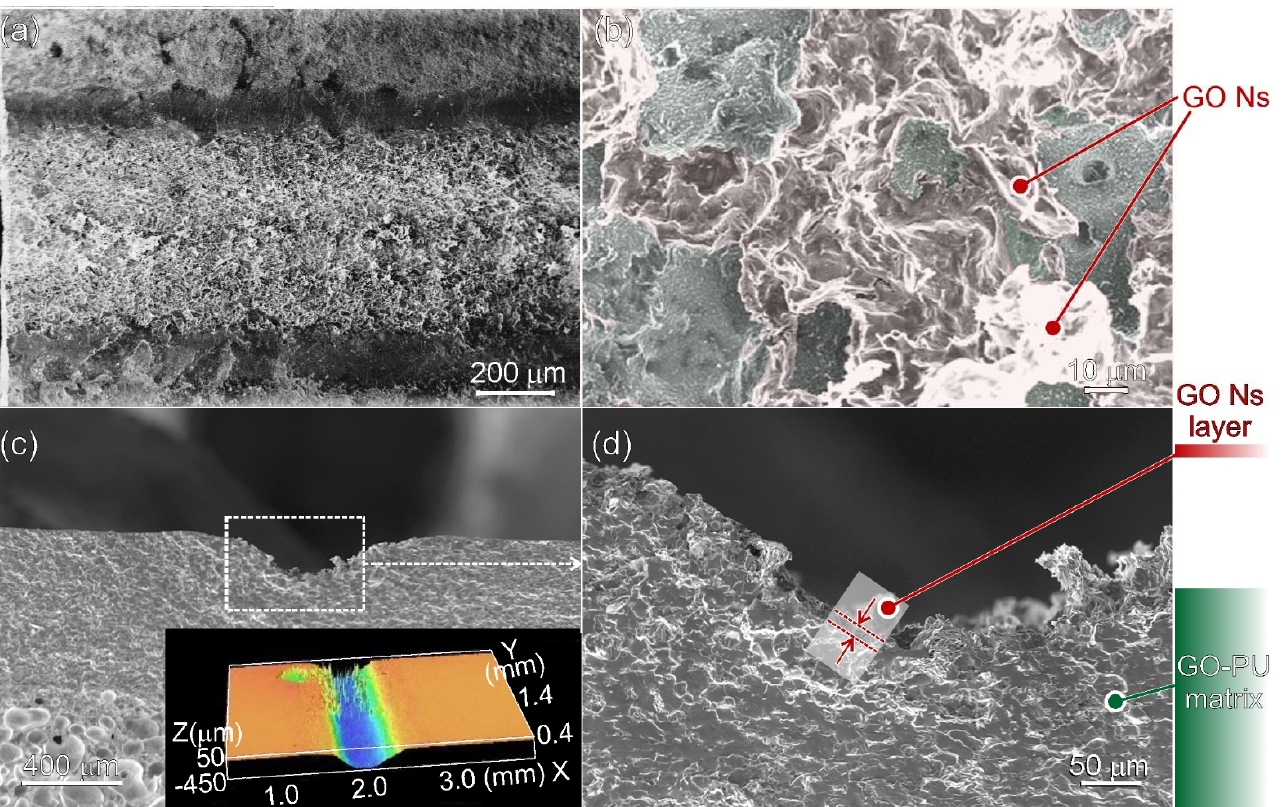
Figure 4. SEM images of a laser-irradiated path: ( a ) low- and ( b ) high-magnification top-view images; ( c ) low- and ( d ) high-magnification cross-sectional views of the GO/PU layer. In the inset of ( c ), an optical 3D profilometry image of the path is illustrated.